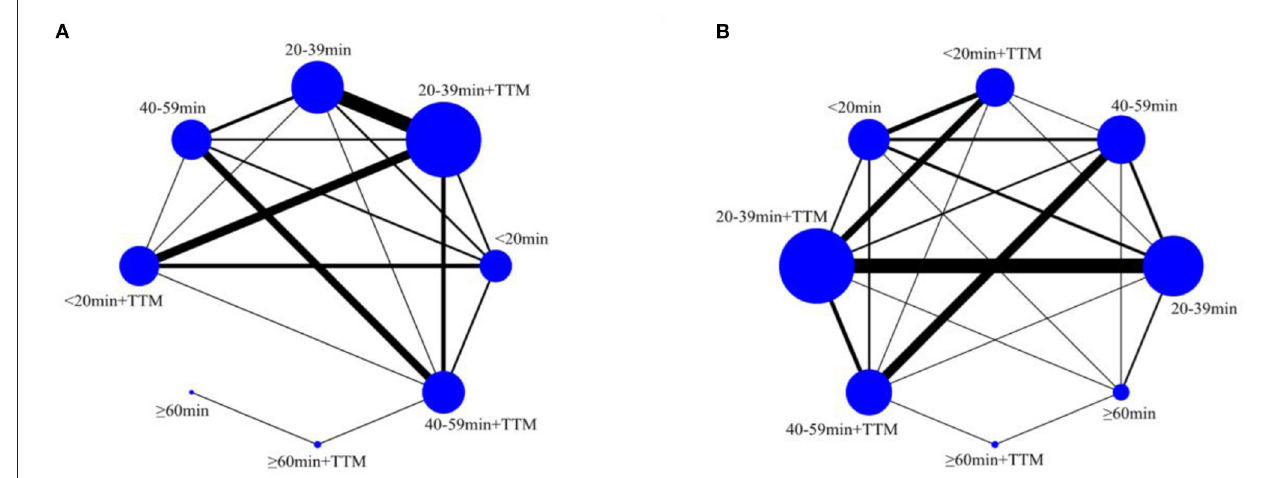
FIGURE 2 | Network plot for 30-day or at-discharge survival (A) and good neurologic outcome (B) .